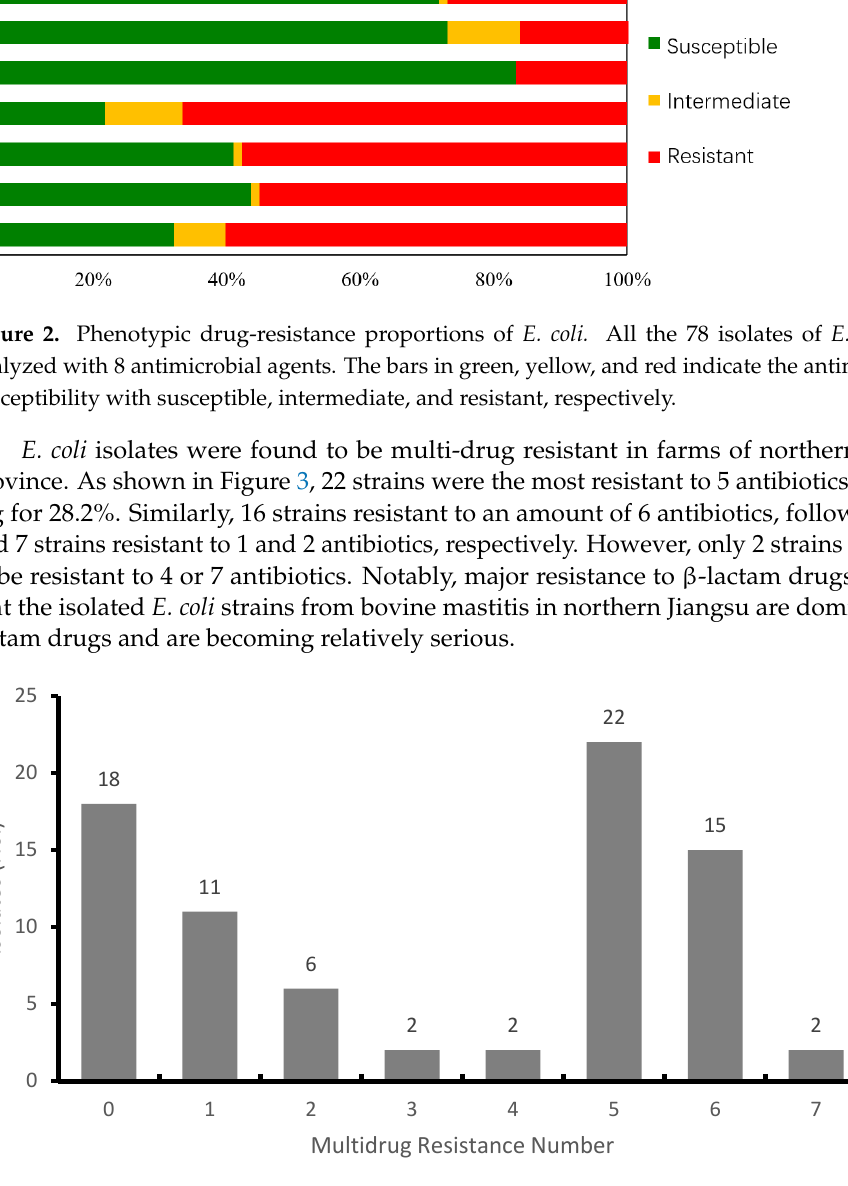
Figure 1. Analysis of 289 strains of pathogenic bacteria of bovine mastitis. All isolates were obtained